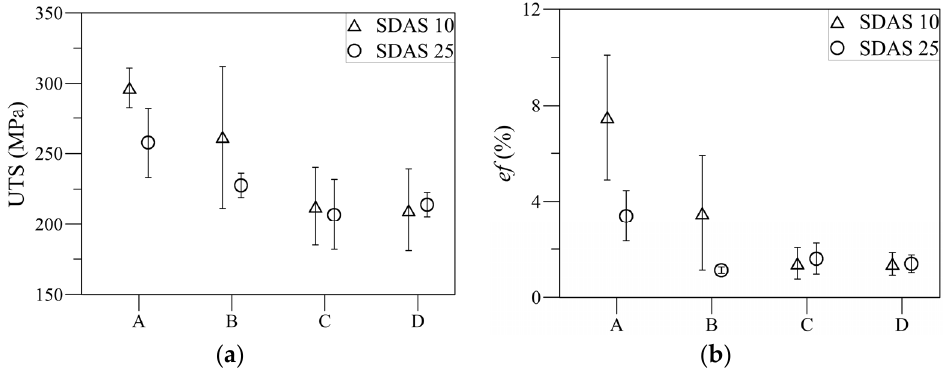
Figure 2. Tensile test results of as-cast samples showing ( a ) UTS and ( b ) e f Error bars show one standard deviation.